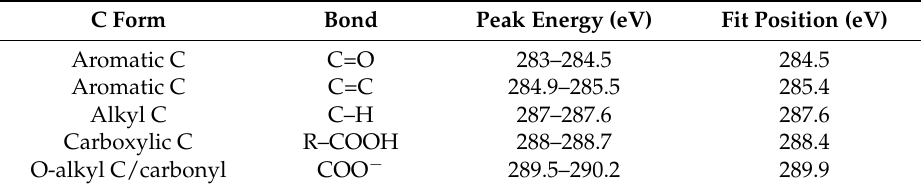
Table 3. C 1s NEXAFS approximate energy ranges and primary absorption peaks